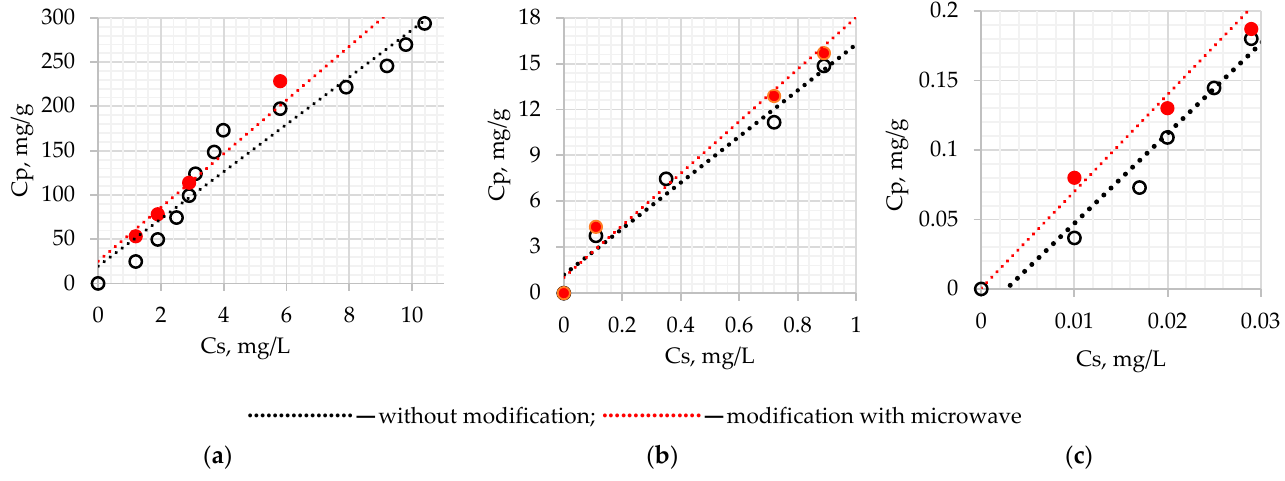
Figure 3. Sorption isotherms of oil products by reindeer moss obtained from aqueous solutions at initial concentration, mg/L, of ( a ) 250, ( b ), 50, and ( c ) 0.5.